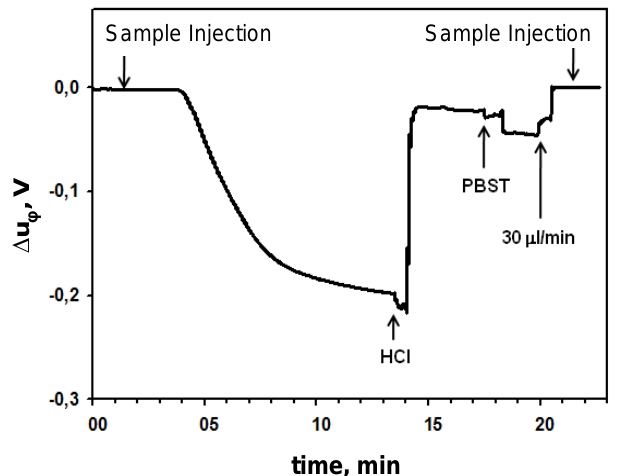
Figure 6. Real-time signal obtained for piezoelectric immunosensor with the phase-shift characterization system.